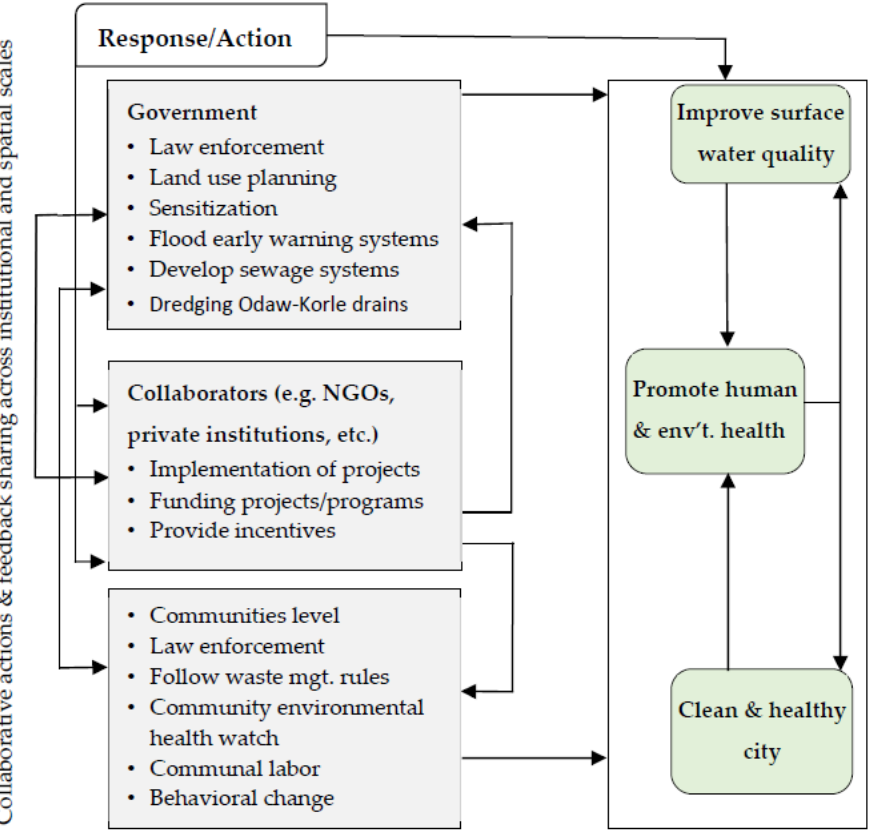
Figure 8. Proposed collaborative strategies to support water quality monitoring and promote health. Summary of proposed collaborative strategies to support water quality monitoring, clean city, and human and environmental health. Here, collaborators may act as a bridging element between the different spatial and institutional scales. Source: based on expert elicitation and stakeholder interactions in workshops in Ghana,